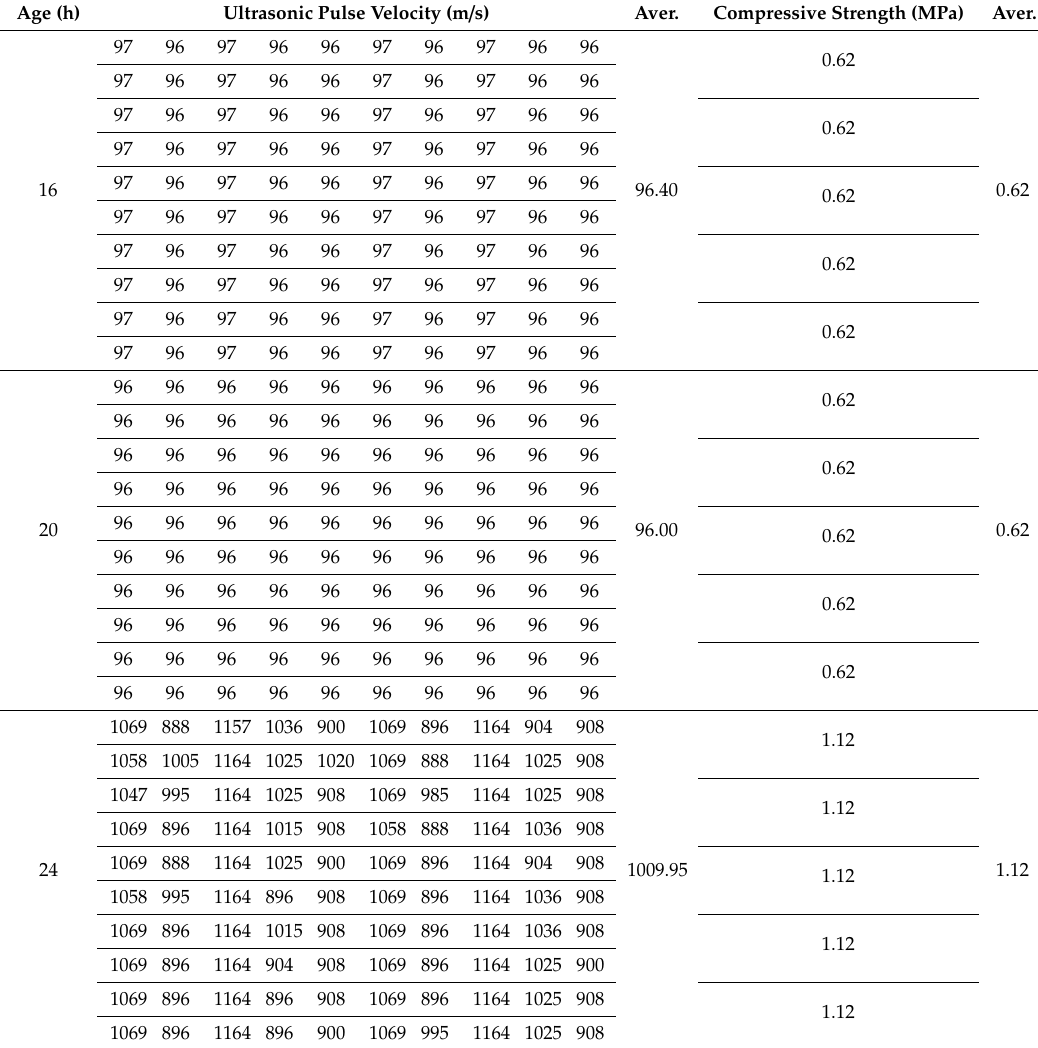
Figure 8. Compressive strength with age (30 MPa). Table 3. Experiment results (30